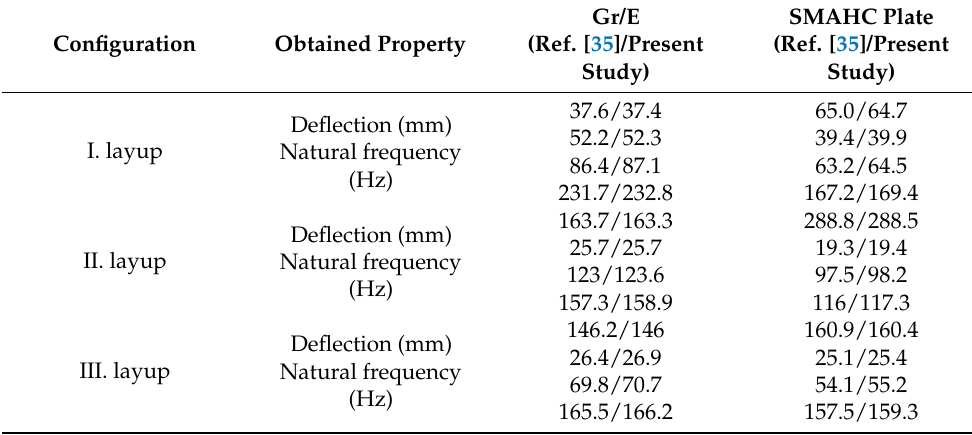
Table 2. Comparison of the deflections and natural frequencies of Gr/E and SMAHC plates.